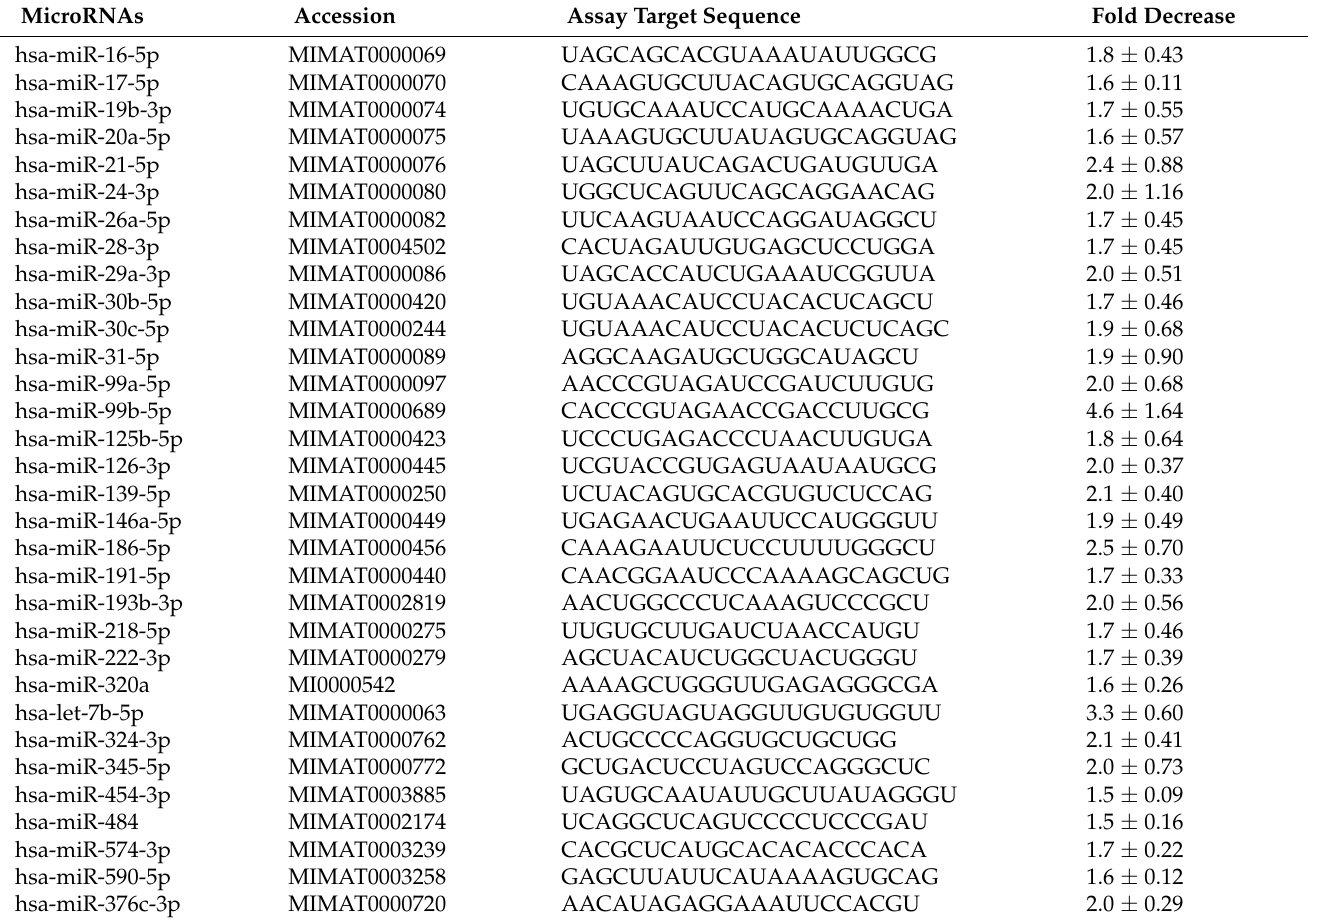
Table 1. Dysregulated miRNAs identified by the microarray analysis after systematic